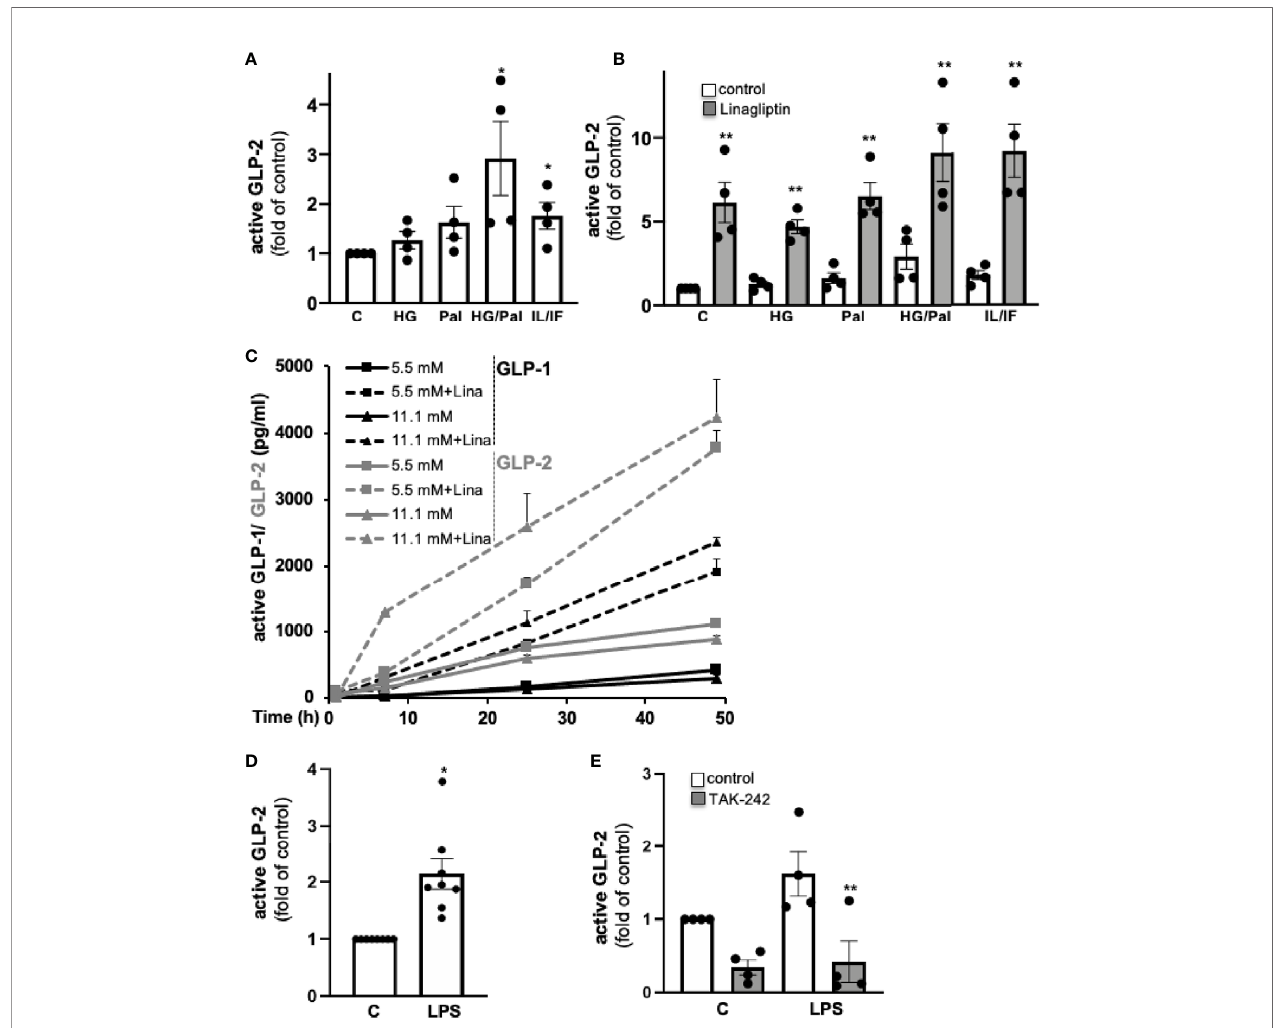
FIGURE 1 | GLP-2 secretion from isolated human islets. Isolated human islets were cultured on ECM-coated dishes (A – C) for 72h or during 49 h (C) with 5.5 mM glucose (control; C), 22.2 mM glucose (HG), 0.5 mM palmitate (Pal), a combination of HG/Pal or cytokines 2 ng/ml IL-1 b /1,000 U/ml IFN- g (IL/IF), in the absence (control) or presence of 30 nM linagliptin, or (D, E) for 24h with 5.5 mM glucose (control; C) or 20 m g/ml LPS in the absence (control) or presence of 10 m M TLR4 inhibitor TAK-242, followed by an ELISA assay of the cell culture supernatants for active GLP-2. Data are normalized to active GLP-2 secretion at untreated control conditions (corresponding to 1.5 ± 0.3 ng/100 islets into the 2 ml culture medium) and shown as means ± SEM from n = 4 (A, B, E) or 8 (D) different human islet isolations. (C) Active GLP-1 and GLP-2 shown as means ± SEM were analyzed from three different islet isolation; data of active GLP-1 are reproduced and thus are transformative from our earlier study (6), where secreted proteins were analyzed during a 49-hour culture of 60 human islets. *p < 0.05 diabetogenic conditions vs . control, **p < 0.05 linagliptin or TAK-242 vs . vehicle control; by paired two-tailed